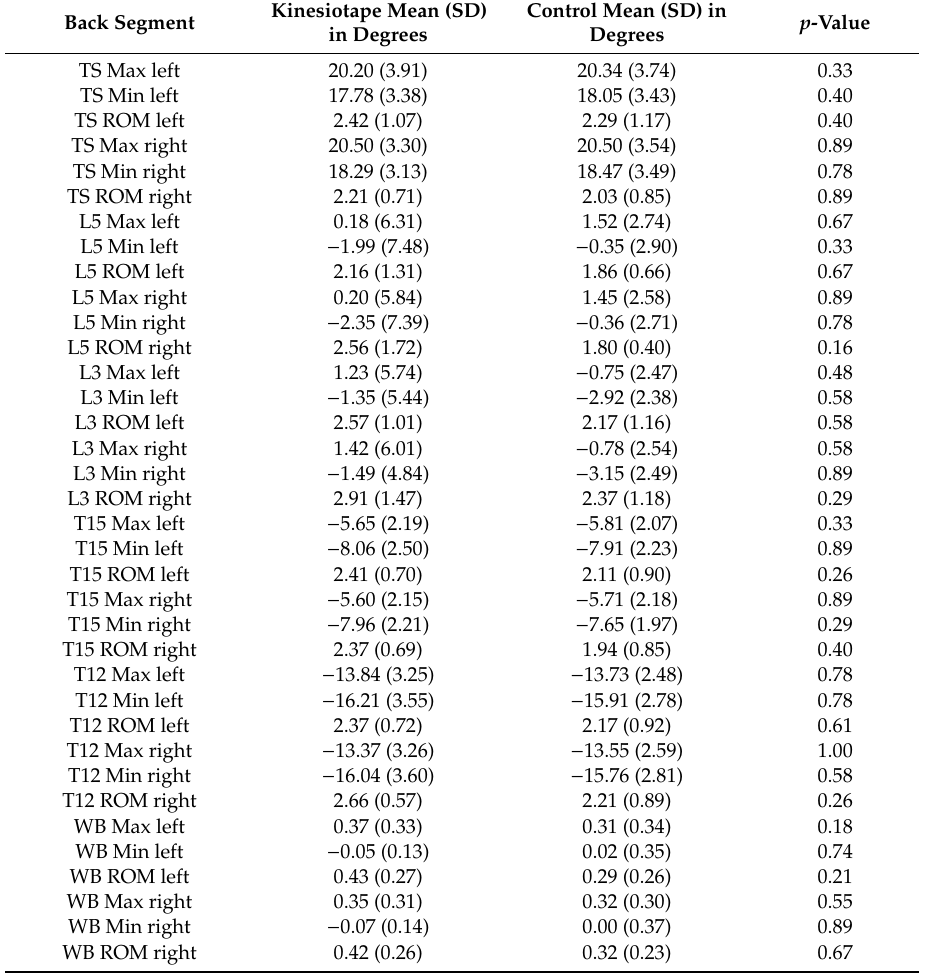
Table 2. Mean, SD and p -values for all horses and back segments. Tuber Sacrale (TS), 5 th Lumbar segment (L5), 3rd Lumbar segment (L3), 15th Thoracic segment (T15), 12th Thoracic segment (T12) and “The whole back” (WB) in degrees in ROM (Range of motion); Kinesiotape and Control group.